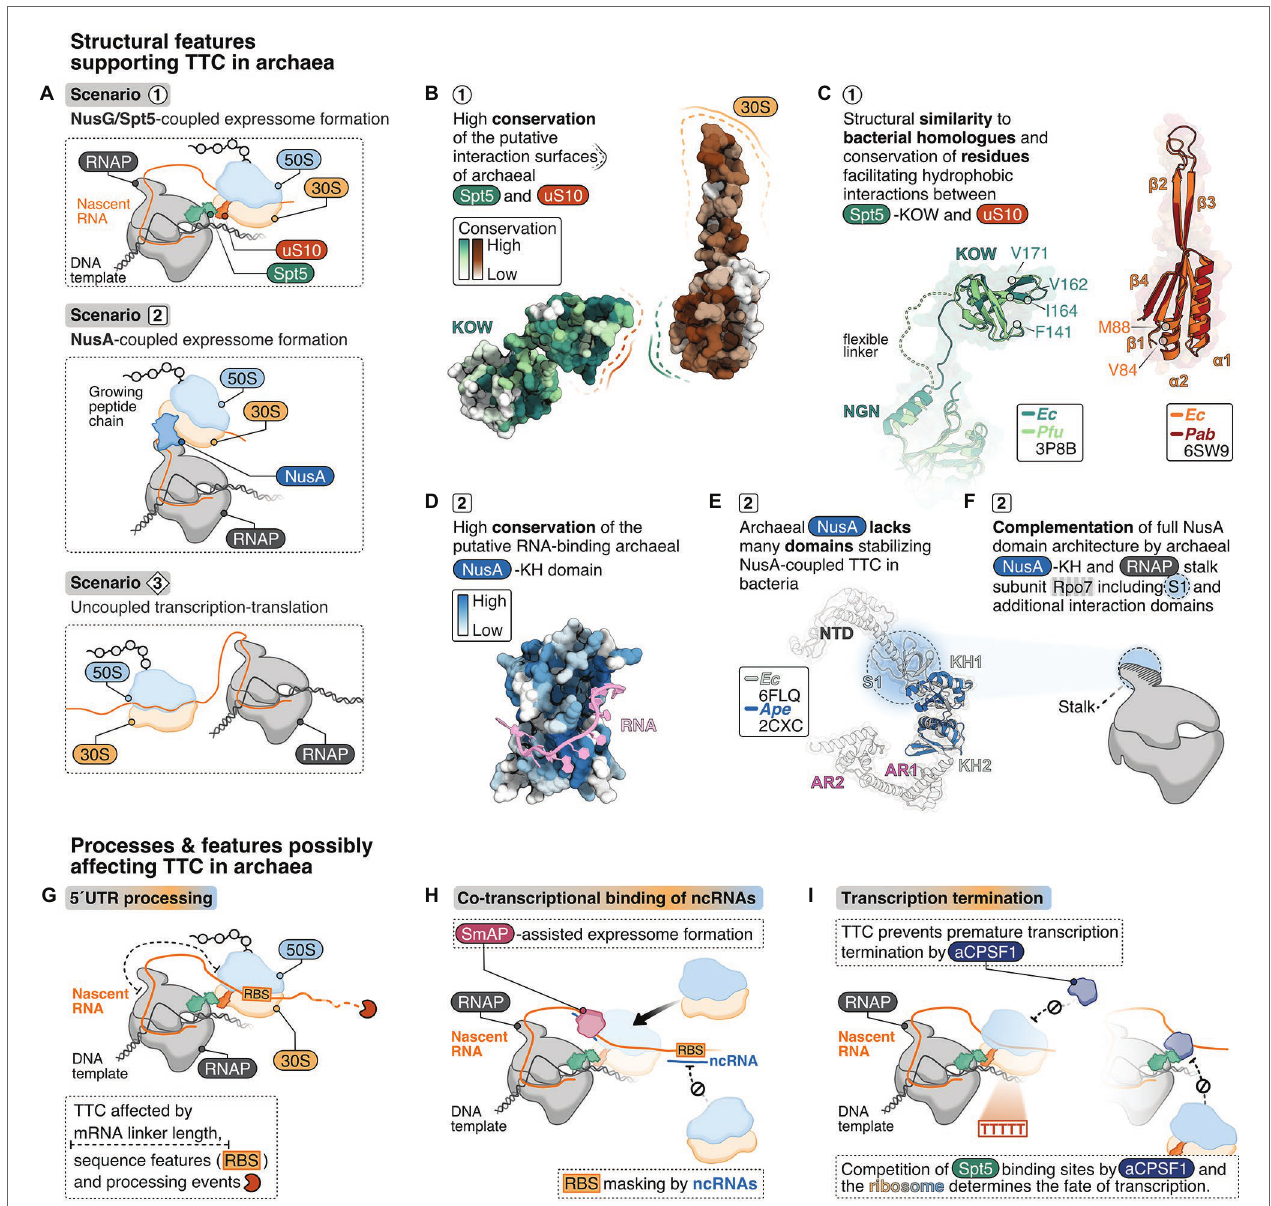
FIGURE 2 | Structural criteria and cellular processes that might mediate and influence transcription-translation coupling in archaea. (A) Possible scenarios for transcription translation coupling (TTC) in archaea derived from structural insights into expressome formation in bacteria: NusG/Spt5-coupled expressome formation is a possible scenario 1 representing the archaeal equivalent to the NusG-coupled state in E. coli (Webster et al., 2020). In addition, one could also imagine NusA-coupling (scenario 2), similar to what has been observed in M. pneumoniae (O’Reilly et al., 2020) or no coupling at all (scenario 3). (B) Analysis of conserved regions in archaeal Spt5 and uS10 using ConSurf (Ashkenazy et al., 2016). About 100 archaeal Spt5 and uS10 sequences were aligned, and their conservation score projected color-coded from white (0, not conserved) to dark green or dark-red (9, highly conserved), respectively, on the surface of Pyrococcus furiosus Spt5 and Pyrococcus abyssi uS10 structure. (C) Superimposition of archaeal and bacterial Spt5/NusG and (bacteria: dark-green, PDB: 6ZTJ, E. coli ; archaea: light-green, PDB: 3P8B, P. furiosus ) and uS10 (bacteria: orange, PDB: 6ZTJ, E. coli ; archaea: red, PDB: 6SW9, P. abyssi ). Residues important for the interaction with NusG are highlighted. (D) Conservation analysis of archaeal NusA proteins. Conservation scores from white (0, not conserved) to dark-blue (0, highly conserved) were calculated based on the comparison of archaeal NusA proteins and projected on the surface of Aeropyrum pernix NusA. A superimposed model of bacterial RNA (Beuth et al., 2005) is shown in pink. (E) The E. coli NusA structure (gray, PDB: 6FLQ) overlayed with A. pernix NusA (Shibata et al., 2007) (blue, PDB: 2CXC). (F) Cartoon depiction of the archaeal RNAP highlighting the hypothesis that the S1 domain of the stalk-forming subunit Rpo7 and the archaeal NusA form a homologue of bacterial NusA. TTC in archaea may be affected by co-transcriptional processes and features depicted in (G – I) , including 5 ' UTR length and processing (G) , co-transcriptional binding of non-coding RNAs (ncRNAs) (H) and the transcription termination pathway (I)